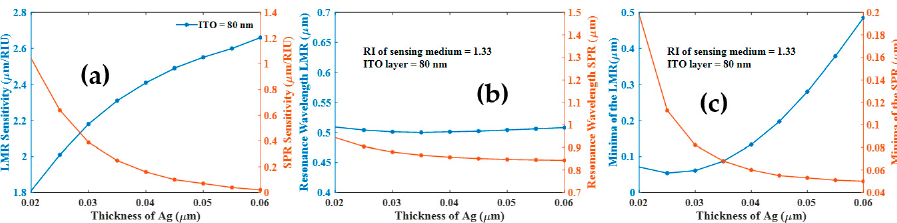
Figure 4. ( a ) Sensitivity ( b ) resonance wavelength and ( c ) minima of the transmission spectra at resonance wavelength of the LMR and SPR modes with the variation of Ag layer when ITO (80 nm) and RIs of the analyte are 1.33 and 1.34.